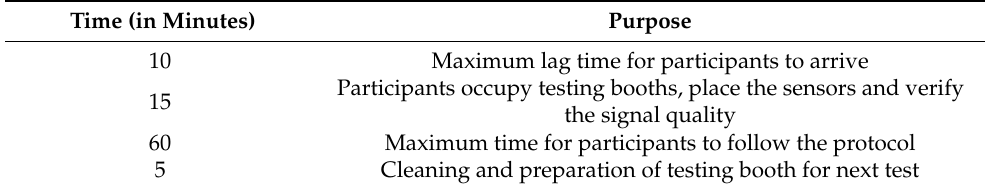
Table 4. Factors considered for the experiment scheduling. Time (in Minutes) Purpose 10 Maximum lag time for participants to arrive Participants occupy testing booths, place the sensors and verify 15 the signal quality 60 Maximum time for participants to follow the protocol 5 Cleaning and preparation of testing booth for next